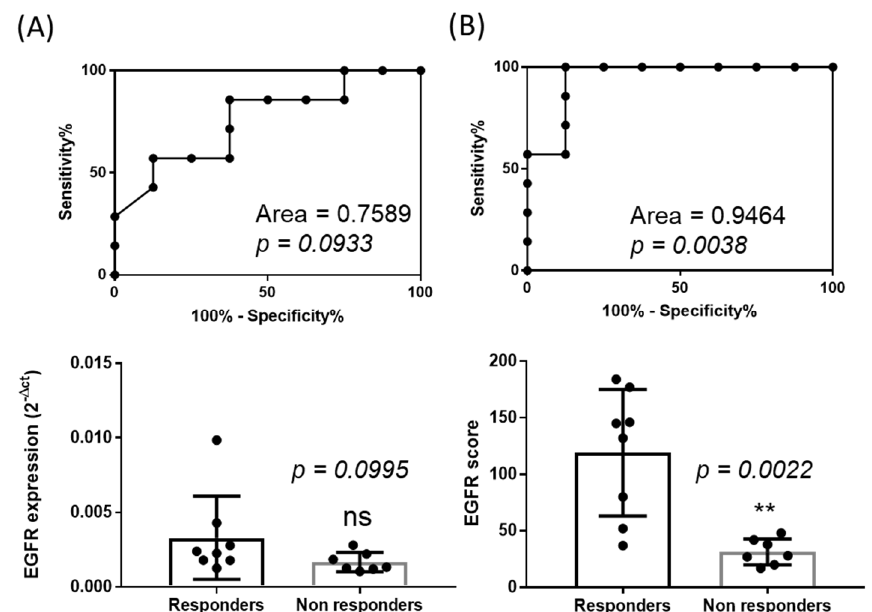
Figure 7. Discrimination of responders versus non-responders. ( A ) ROC curve analysis of the non-normalized expression of EGFR (2 − ∆ Ct ) according to the objective response to Cetuximab (defined as responder if (dt / dc)% < 10% and non-responder if > 10%) in the cohort of 15 patient-derived tumor xenografts models. ( B ) ROC curve analysis of the normalized expression of EGFR (sum of 2 − ∆∆ Ct further normalized to 1000) according to the objective response to Cetuximab (defined as responder if (dt / dc)% < 10% and non-responder if > 10%) in the cohort of 15 patient-derived tumor xenografts models. Median expression of EGFR before normalization (C, 2 − ∆ Ct ) or after normalization (D, sum of 2 − ∆∆ Ct further normalized to 1000). Mann-Whitney test (ns: not significant; ** p < 0.01).